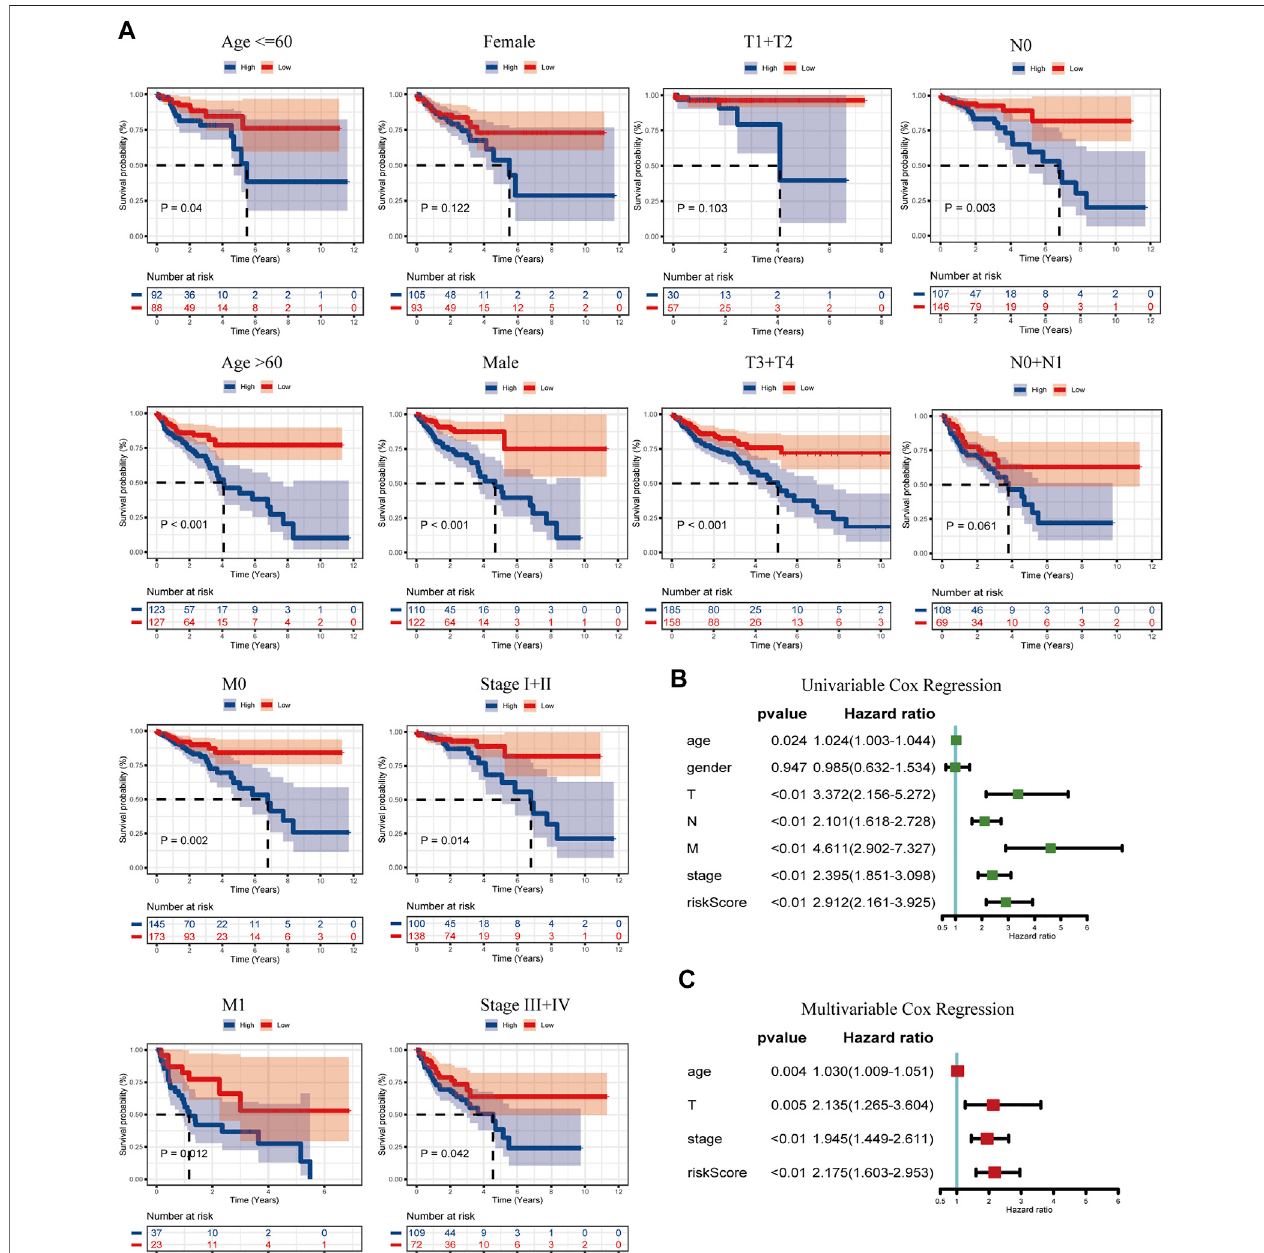
FIGURE 4 | K – M curves of the risk model classi fi ed by clinicopathology features (A) , including age ( ≤ 65 years and > 65 years), gender (female and male), T (T1+T2 and T3+T4), N (N0 and N1+N2), M (M0 and M1), and stages (I + II and III + IV). (B) Univariable Cox regression of the risk score linked with clinicopathology characters(age,gender, T,N,M, stage, and riskscore). (C) Multivariable Coxregressionoftheriskscorecombinedwiththe screened clinicopathology characters (age, T, stage, and risk score).